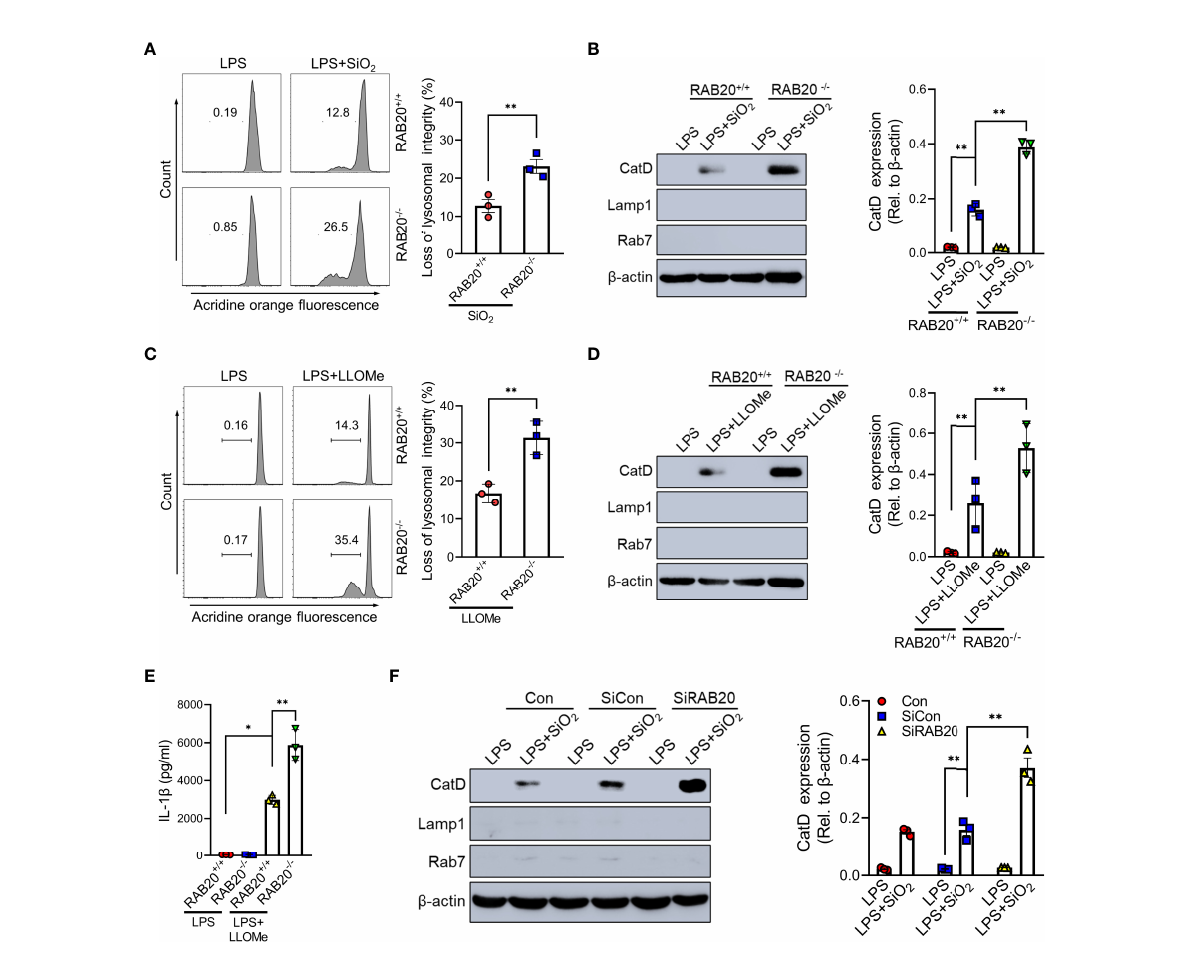
FIGURE 5 RAB20 knockout induced silica crystal-induced NLRP3 in fl ammasome activation by triggering lysosomal rupture. (A) Immunoblotting for Cathepsin D, RAB7, Lamp1, and b -actin in the cytosolic fraction from RAB20 +/+ and RAB20 -/- mouse peritoneal macrophages stimulated with SiO 2 after LPS priming. (B) Flow cytometry of RAB20 +/+ and RAB20 -/- mouse peritoneal macrophages that stained with acridine orange and then treated with SiO 2 after LPS priming. (C) Immunoblotting for Cathepsin D, RAB7, Lamp1, and b -actin in the cytosolic fraction from RAB20 +/+ and RAB20 -/- mouse peritoneal macrophages stimulated with Leu-Leu-OMe after LPS priming. (D) Flow cytometry of RAB20 +/+ and RAB20 -/- mouse peritoneal macrophages that stained with acridine orange and then treated with Leu-Leu-OMe after LPS priming. (E) IL-1 b secretion in RAB20 +/+ and RAB20 -/- mouse peritoneal macrophages stimulated with Leu-Leu-OMe after LPS priming. (F) Immunoblotting for Cathepsin D, RAB7, Lamp1, and b -actin in the cytosolic fraction from THP1 cells with RAB20 siRNA and then stimulated with SiO 2 after LPS priming. *p < 0.05; **p < 0.01 (unpaired/two-tailed t test, one-way and two-way ANOVA test). Data are shown as mean ± SEM from three independent